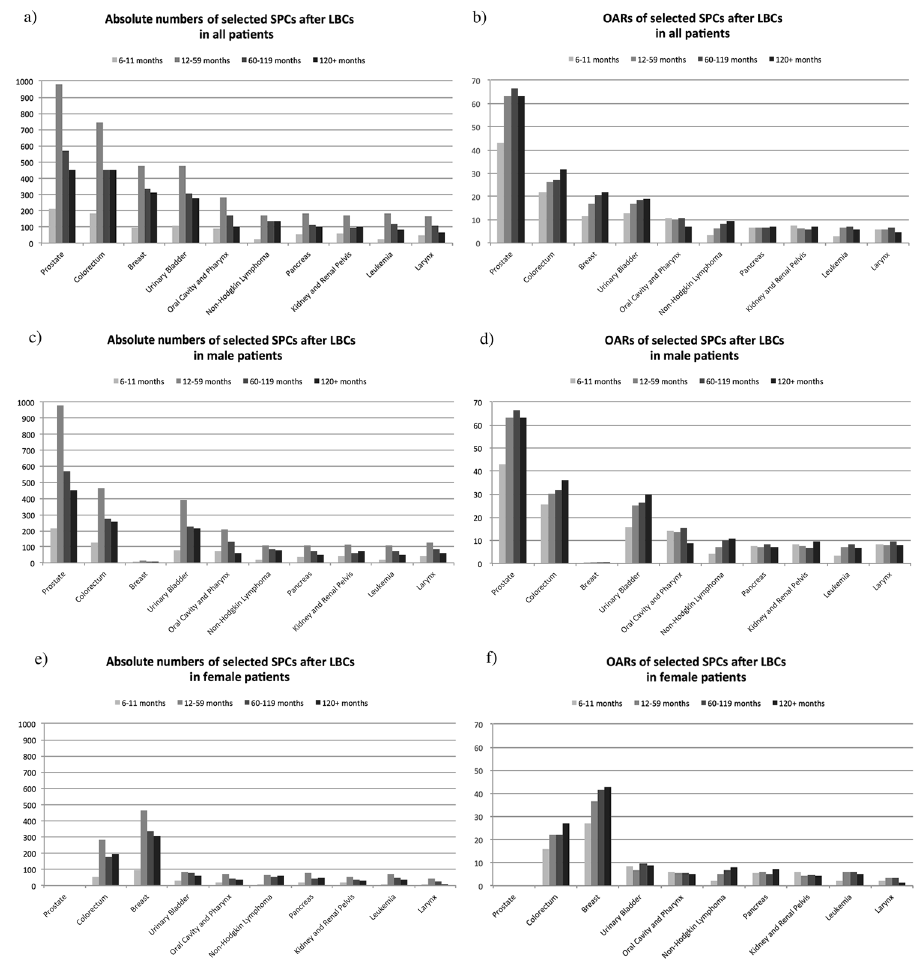
Figure 2. Absolute numbers and observed annual risks (OARs) of selected subsequent primary cancers (SPCs) after lung and bronchus caners (LBCs), by latency and